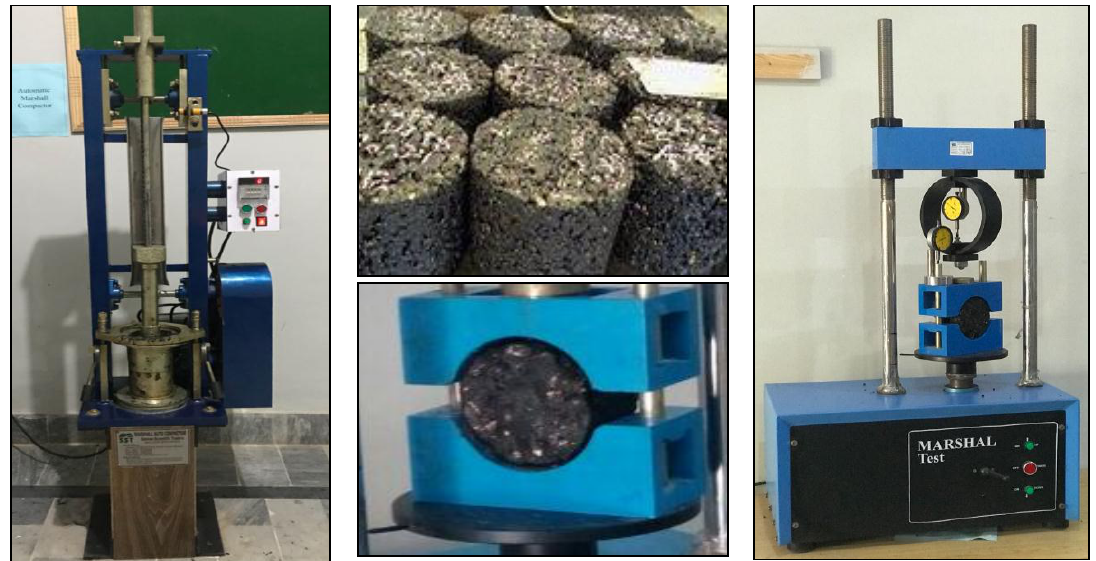
Figure 3. Marshall testing machine with asphalt specimen and compactor apparatus.